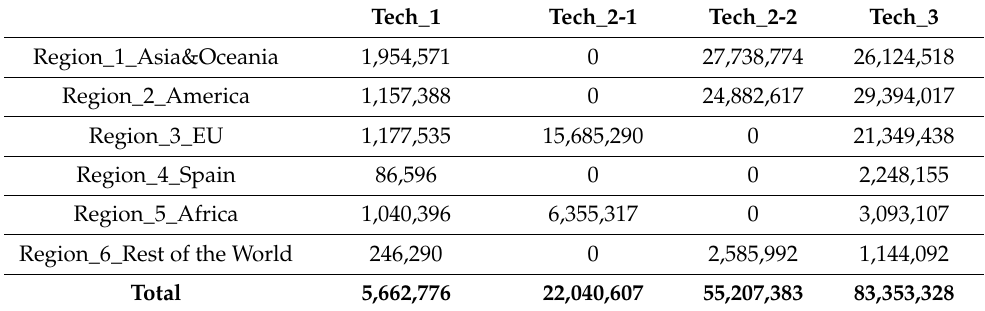
Table 10. Water split H M L, 2 technologies, M as L. Solution of x by region and technology (million $).